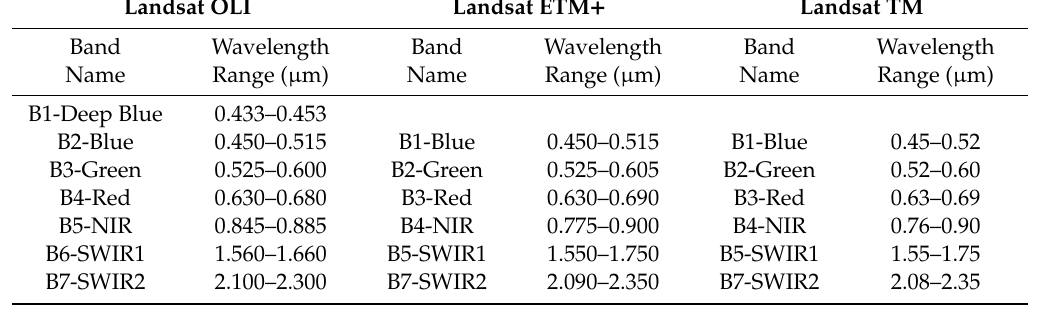
Table 1. Basic characteristics of Landsat Operational Land Imager (OLI), Enhanced Thematic Mapper Plus (ETM + ) and Thematic Mapper (TM) data.